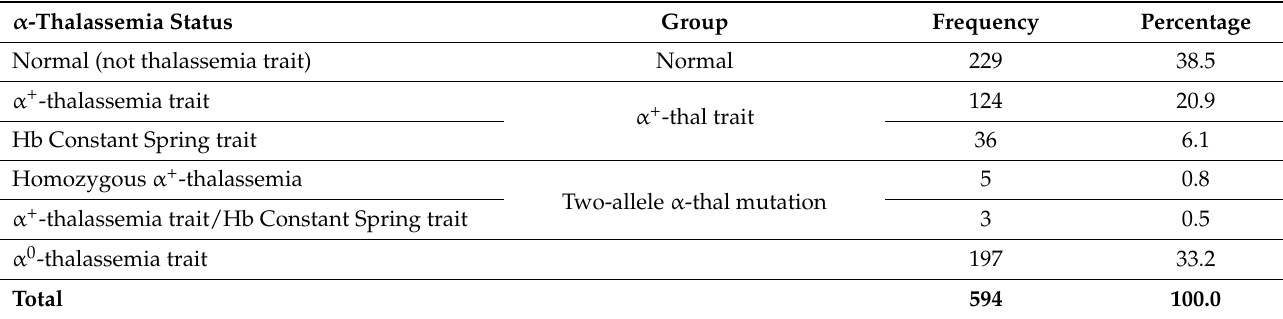
Table 1. Distribution of the α -thalassemia